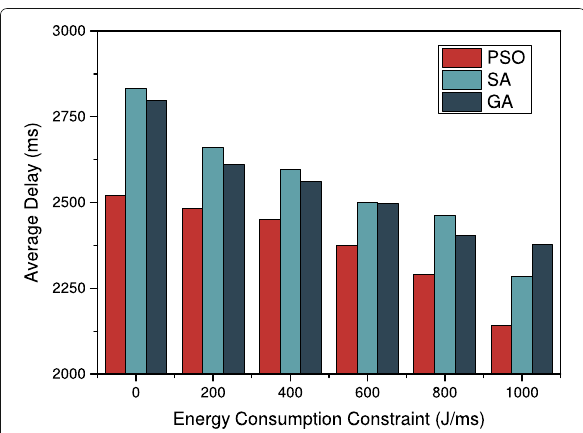
Fig. 6 Comparison of average delay of the three offloading strategies under different energy consumption constraints